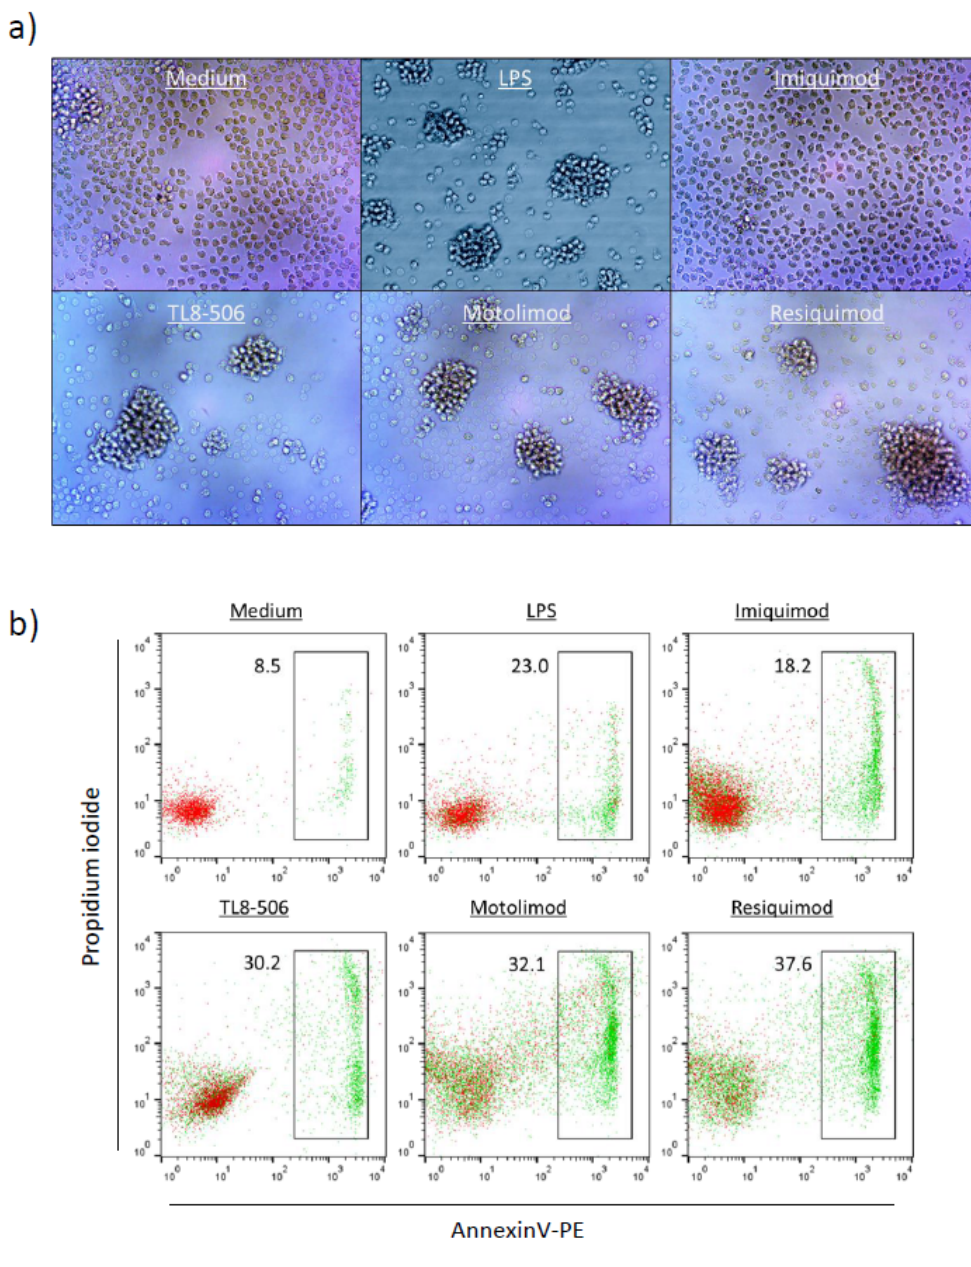
Cells 2020 , 9 , x FOR PEER REVIEW 2 of Figure 5 :